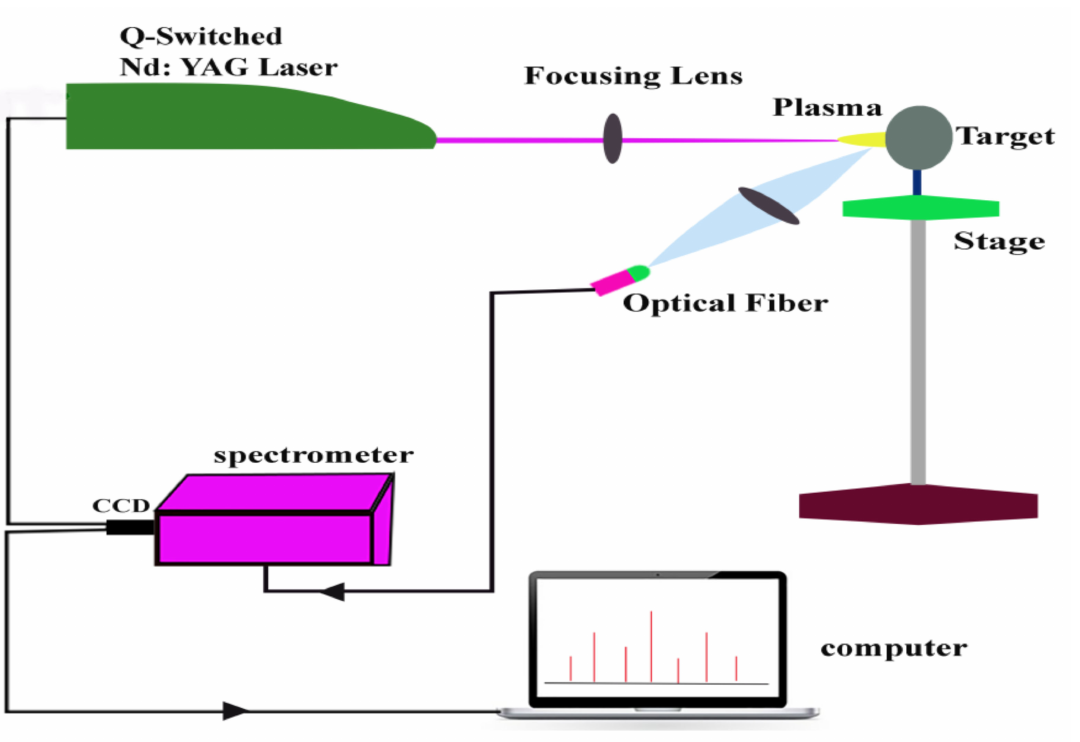
Figure 1. Schematic diagram of LIBS2000+ experimental setup.